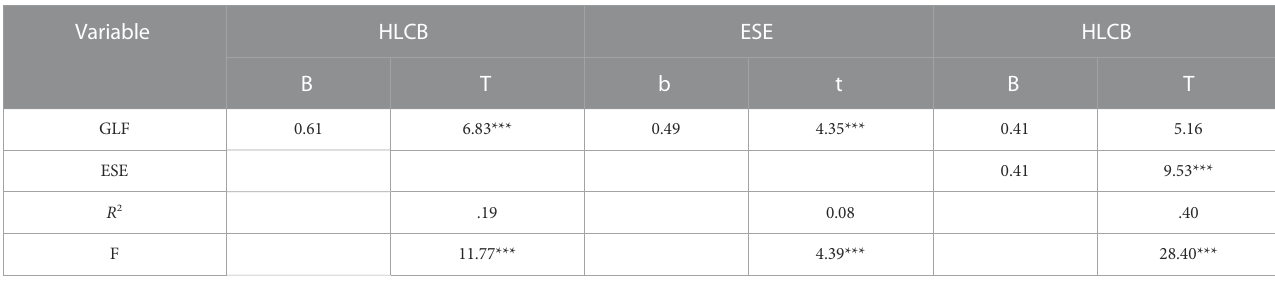
TABLE 3 Check for the mediating role.